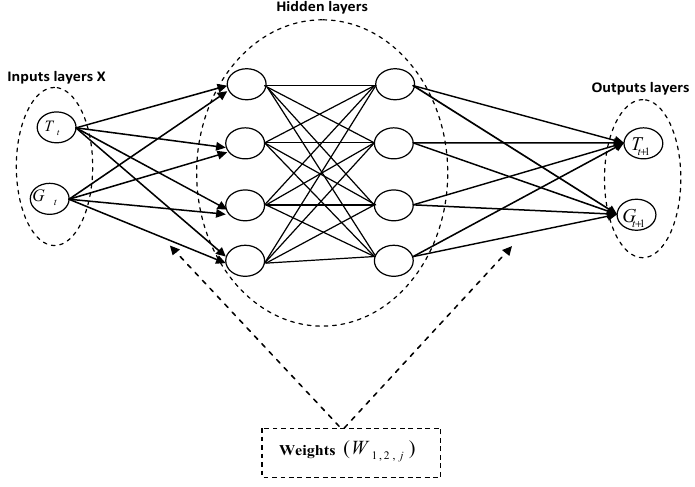
Figure 3. Neural network architecture.